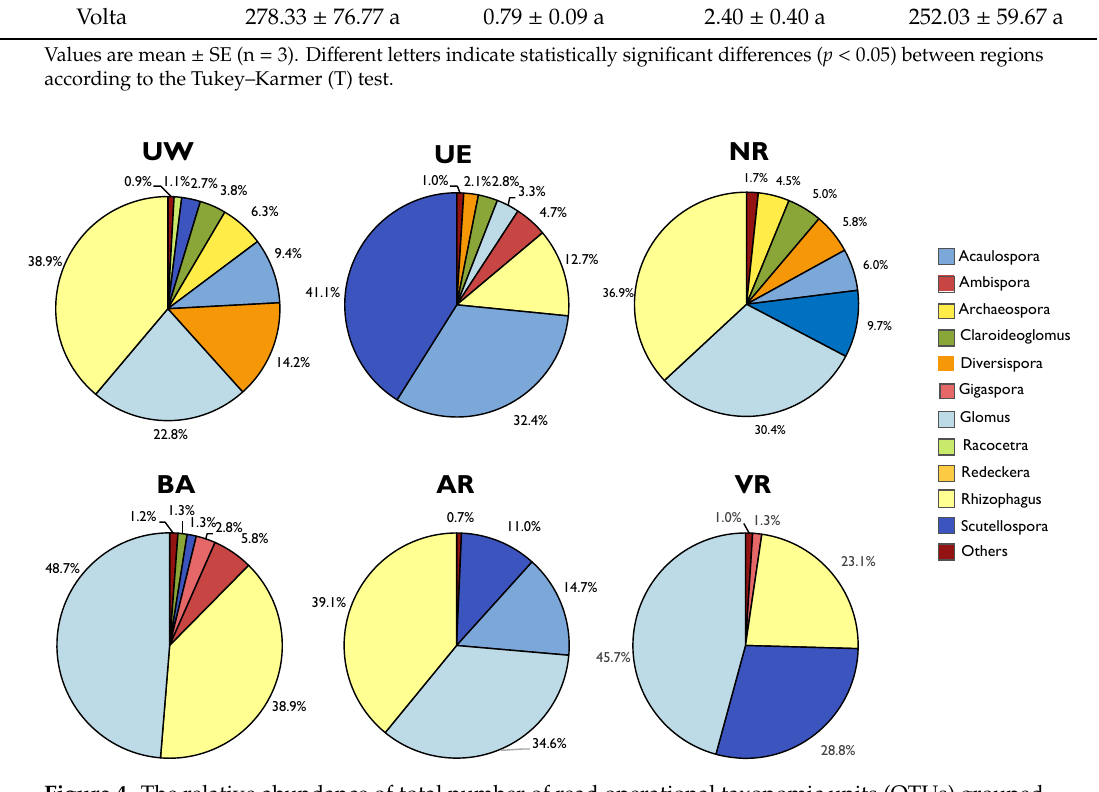
Figure 4. The relative abundance of total number of read operational taxonomic units (OTUs) grouped by AMF genus among six di ff erent regions in Ghana. UW: Upper West; UE: Upper East; NR: Northern; AR: Ashanti; VR: Volta. Table 3. PERMANOVA analysis of the e ff ect of available P, carbon-to-nitrogen ratio (C / N), NO 3 − and their interactions on the distribution of AMF OTUs in analyzed rice roots sampled from six di ff erent regions across Ghana. * p <